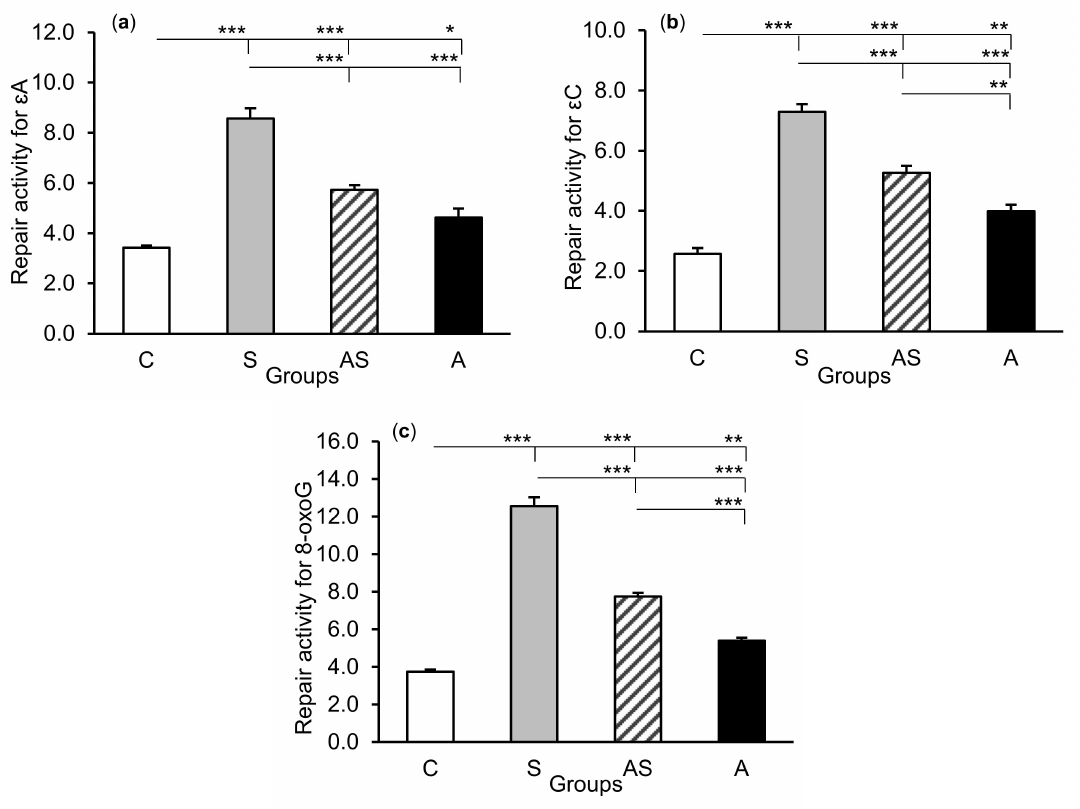
Figure 7. Repair activities (fmol / µ g protein / h) for 1, N 6 -ethenoadenine ( ε A), ( a ) 3, N 4 -ethenocytosine ( ε C), ( b ) and 8-oxoguanine (8-oxoG), ( c ) in the central amygdaloid nucleus of sheep treated with: vehicle (C), vehicle and stressful stimuli (S), allopregnanolone and stressful stimuli (AS), and allopregnanolone alone (A). Significance of di ff erences: * p < 0.05, ** p < 0.01, *** p <